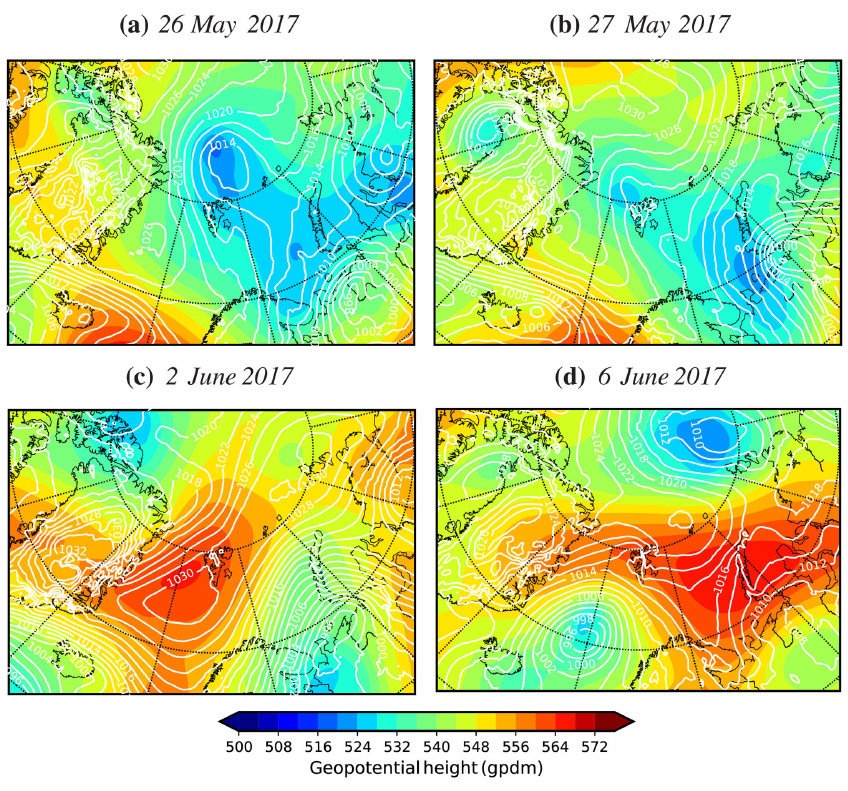
Figure 3. Sea level pressure (in hPa; white contours) and 500hPa geopotential height (in meters; shading) for 12:00UTC on (a) 26 May, (b) 27 May, (c) 2 June, and (d) 6 June 2017, from